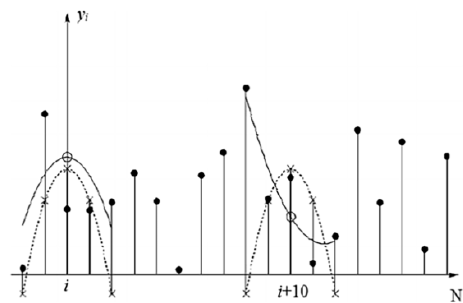
Figure 4. Illustration of least-squares smoothing by locally fitting a low-order polynomial (solid line) to five input samples: dot denotes the raw input samples, circle denotes the least-squares smoothed samples, and x denotes the effective impulse response samples. The dotted line denotes the polynomial approximation to centered unit impulse. This figure was taken from [41].